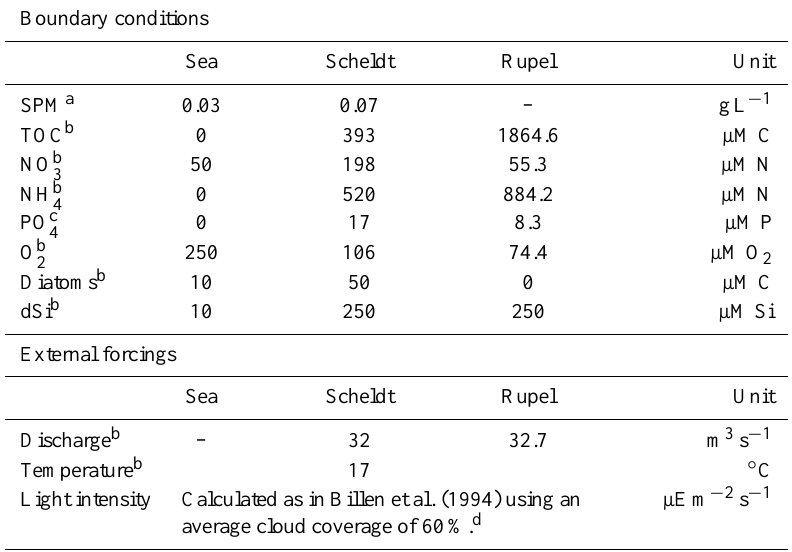
Table 3. Boundary conditions and external forcings for the steady-state simulation. a Arndt et al. (2007), b Vanderborght et al. (2007), c Van der Zee et al. (2007). d Typical value for a summer period in Belgium (IRM, 2004). Boundary